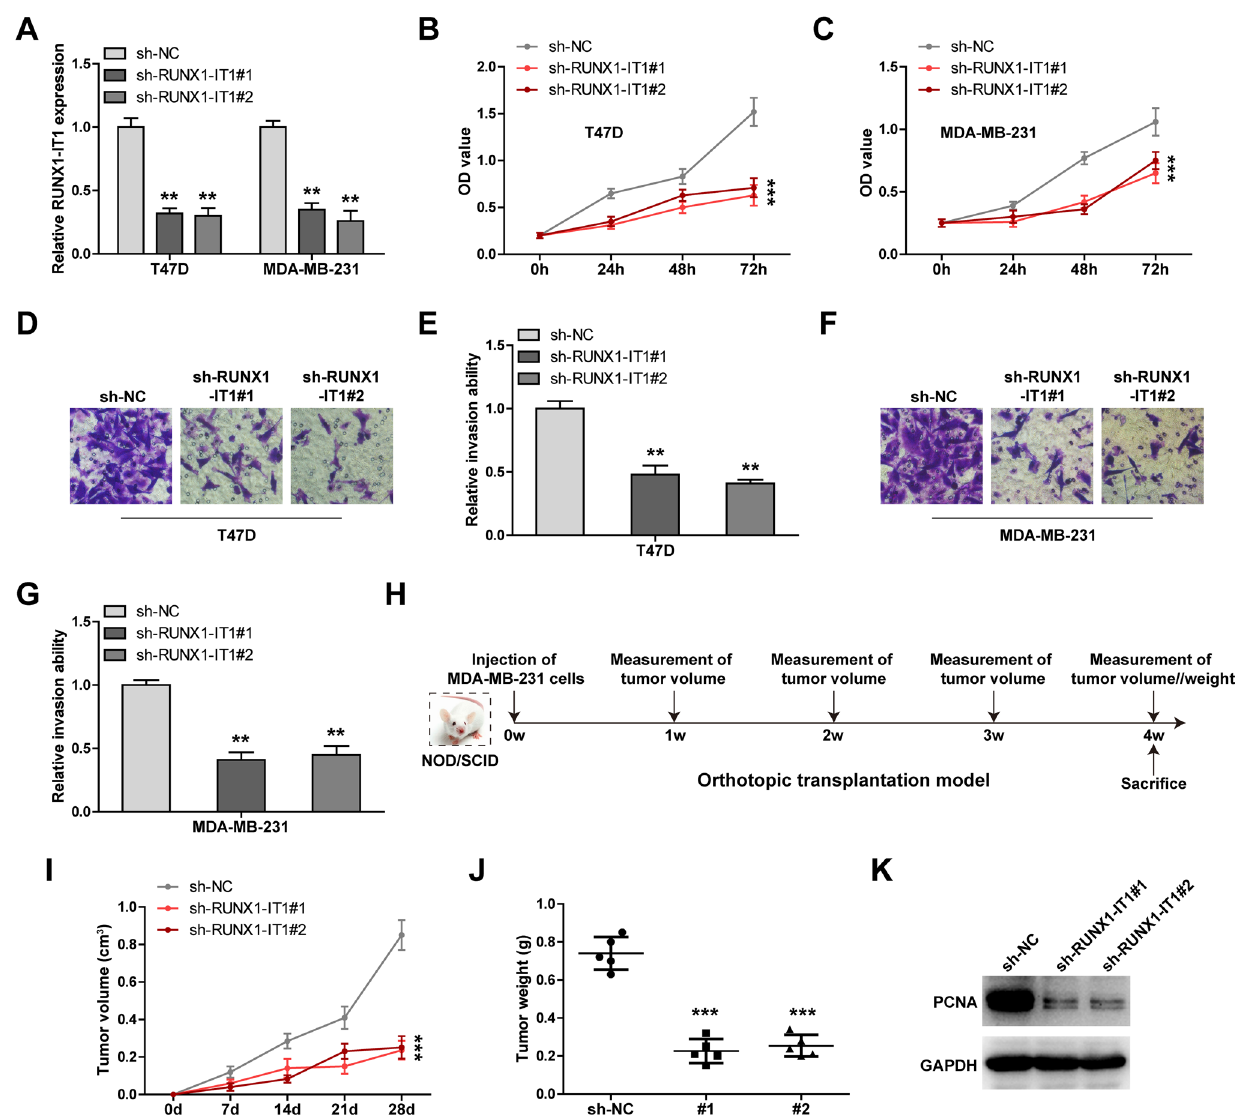
Fig. 2 Identification of RUNX1-IT1 function in breast cancer. A qRT-PCR verifying the knockdown efficiency of RUNX1-IT1. B , C CCK-8 assay testing cell viability in cells with RUNX1-IT1 silencing. D – G Transwell assay testing cell invasion after RUNX1-IT1 silencing. H The flowchart showing the protocol of establishment of orthotopic transplantation model. I, J. Tumor volume and weight of mice in the indicated groups. K Western blot testing PCNA levels in the indicated groups. GAPDH was used the loading control. ** P < 0.01, *** P <